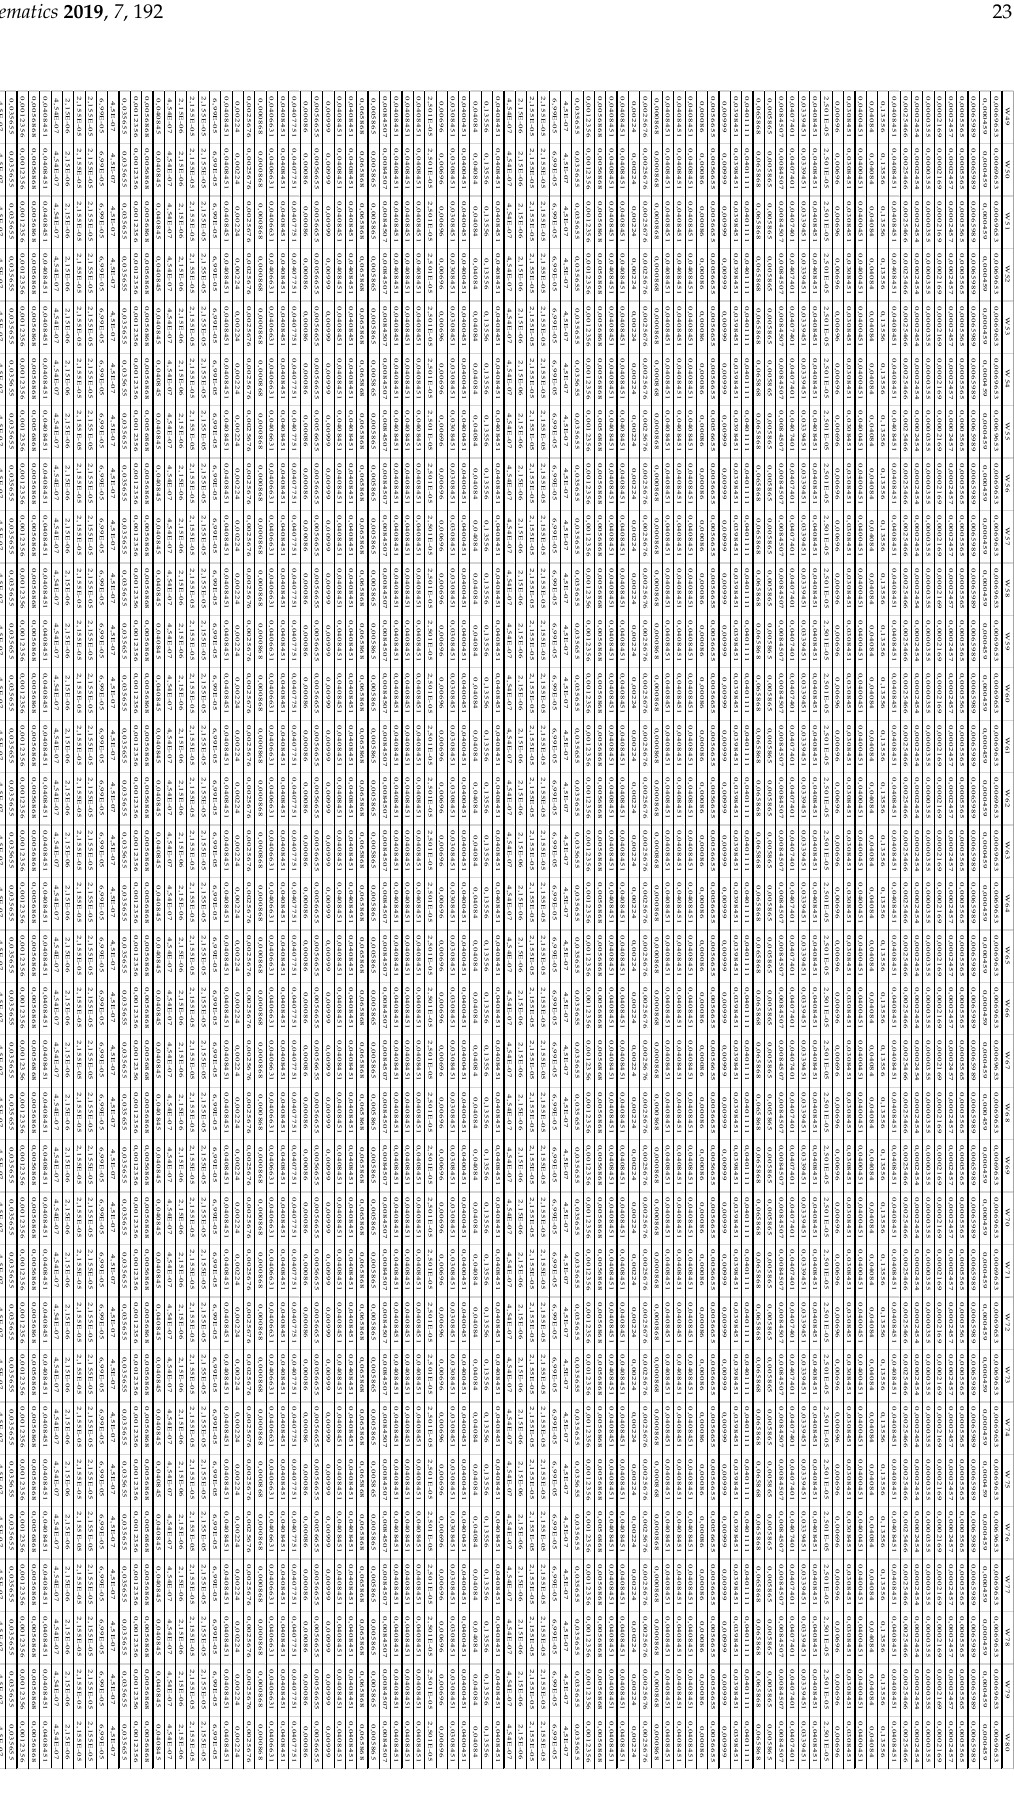
Figure A3. Limit super matrix of the ANP calculations (cont.)